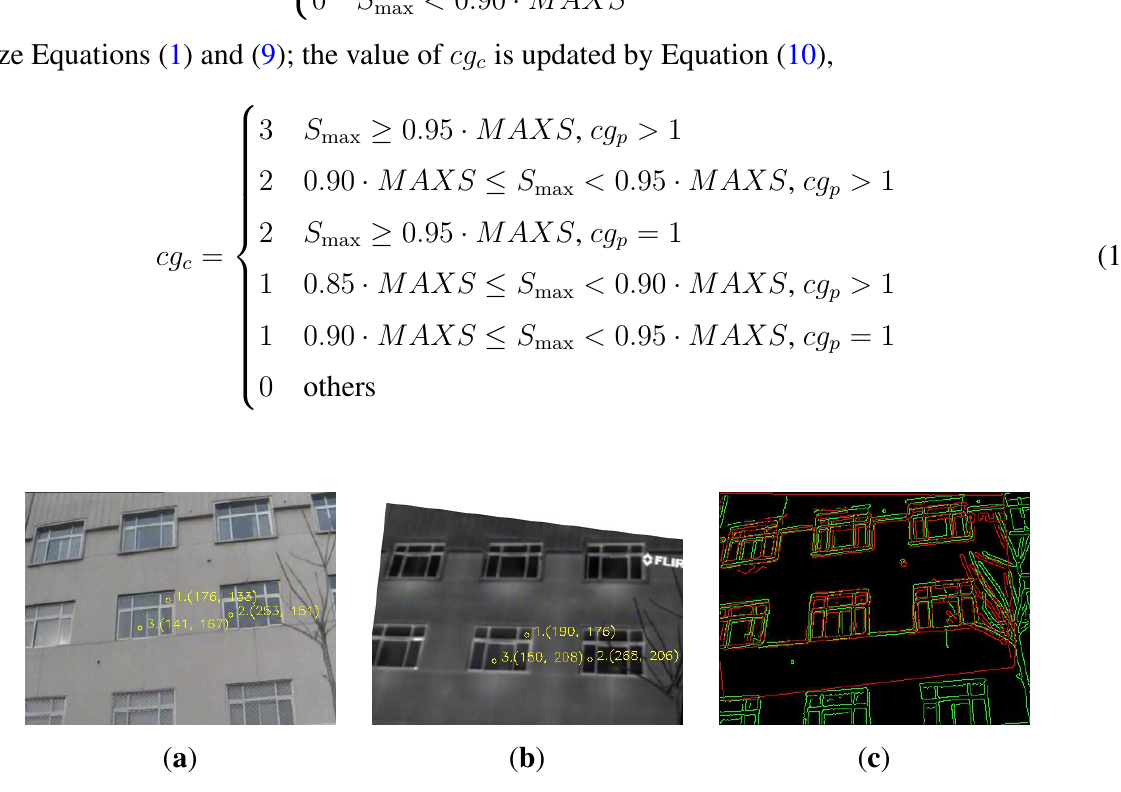
( x, y ) ; ( b ) I T ( x, y ) , illustrating three keypoint mappings that are to Figure 4. ( a ) I r t